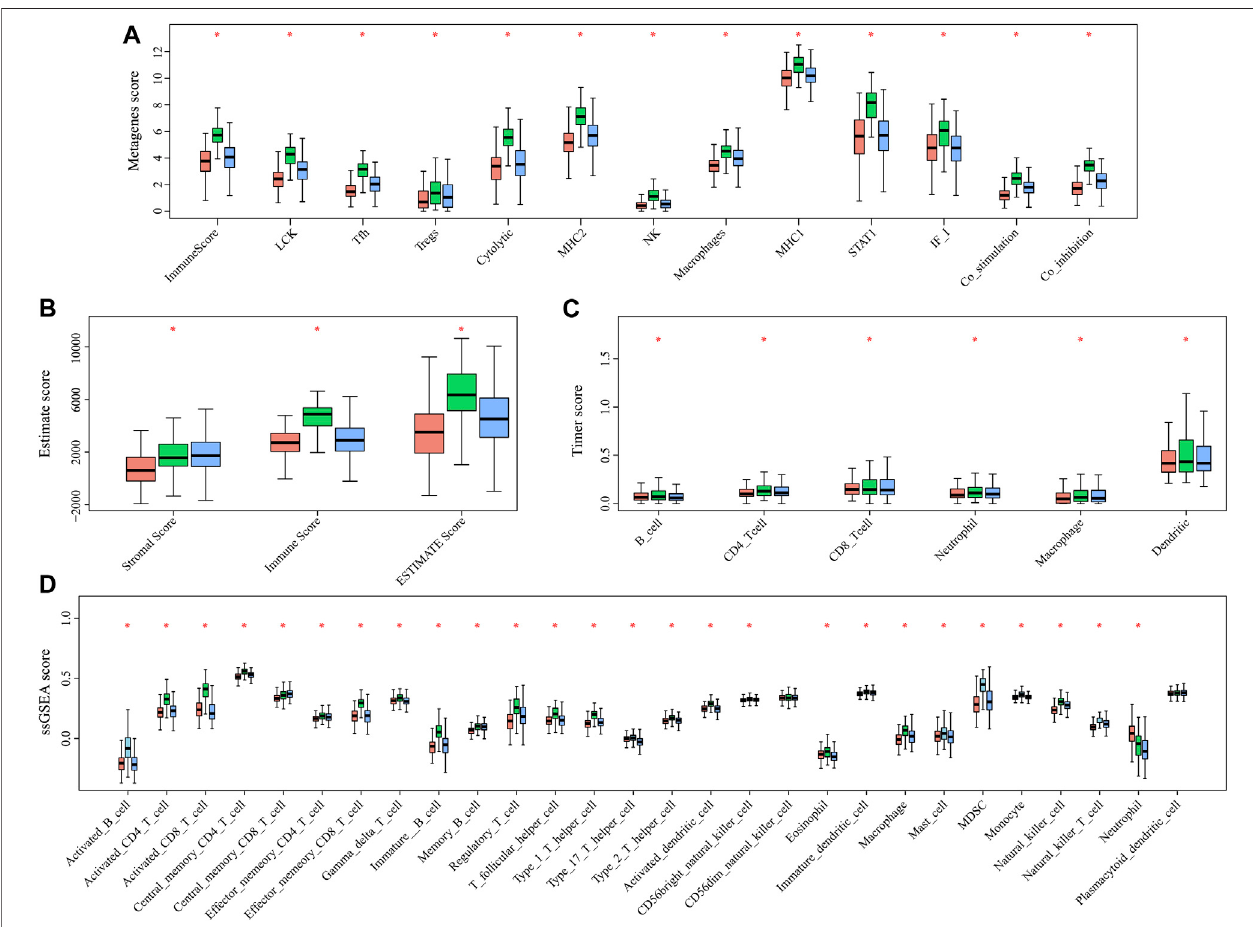
FIGURE 4 | Multiple immune scores of the three HNSCC subtypes in the TCGA cohort. (A) Expression scores of 13 types of metagenes of the three HNSCC subtypes. (B) Boxplots indicating the tumor stroma scores, the immune scores, and the ESTIMATE scores of the three HNSCC subtypes. (C) Scores of six types of immune in fi ltrating cells of the three HNSCC subtypes. (D) Scores of 28 immune-related pathways of the three HNSCC